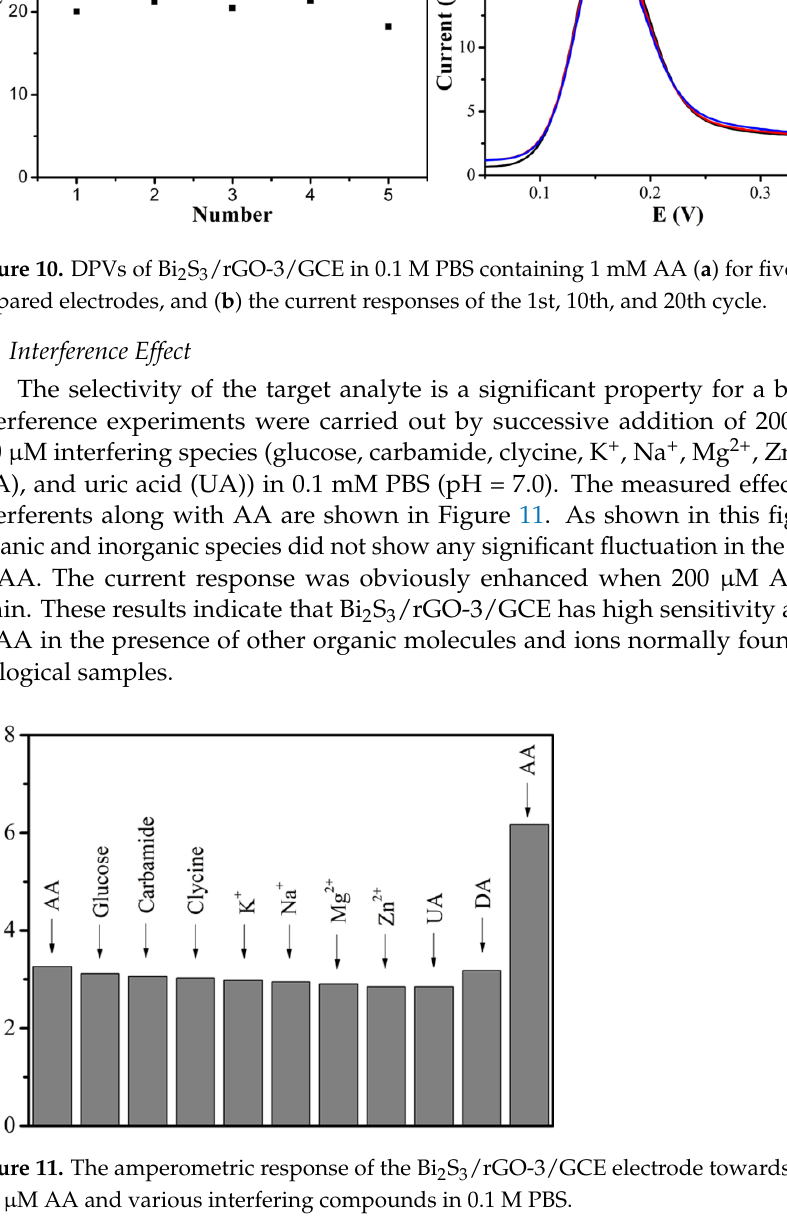
Table 2. Determination of AA in vitamin C tablets ( n = 3).